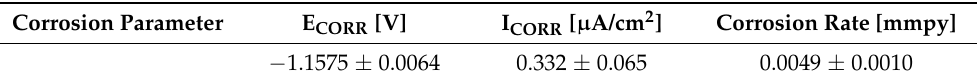
Figure 3. Typical cyclic potentiodynamic polarization analysis of Zn-2%Fe-0.6%Ca alloy in PBS solution. Table 2. Tafel extrapolation measurements obtained from the cyclic potentiodynamic poilariza- tion